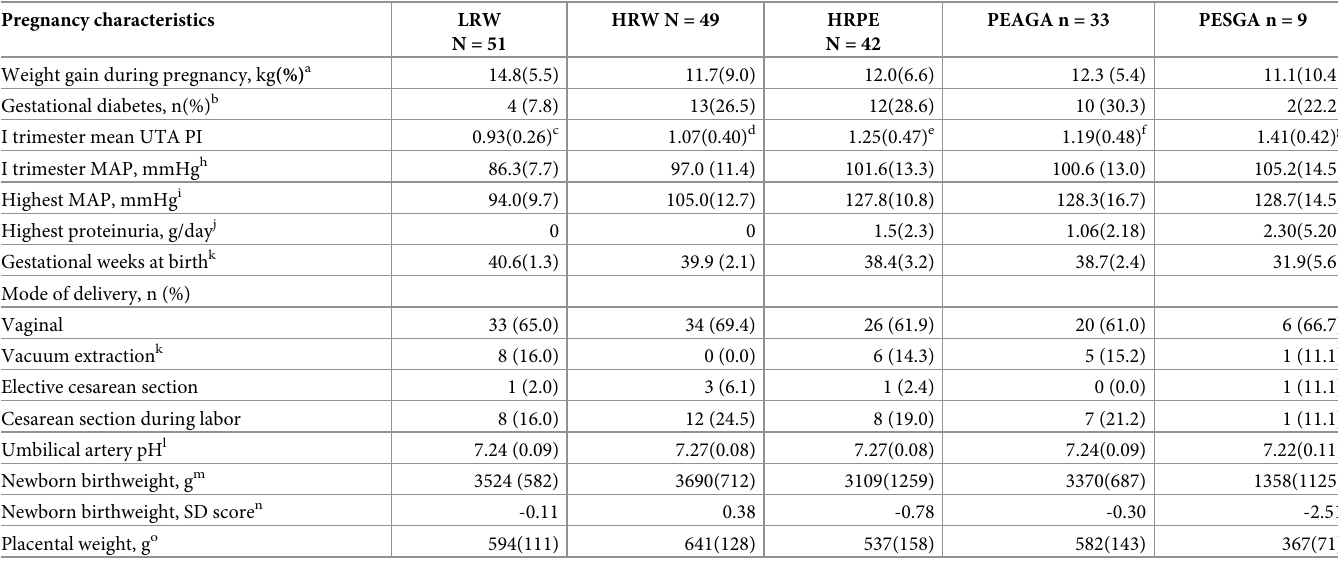
Table 3. Pregnancy characteristics of study groups.